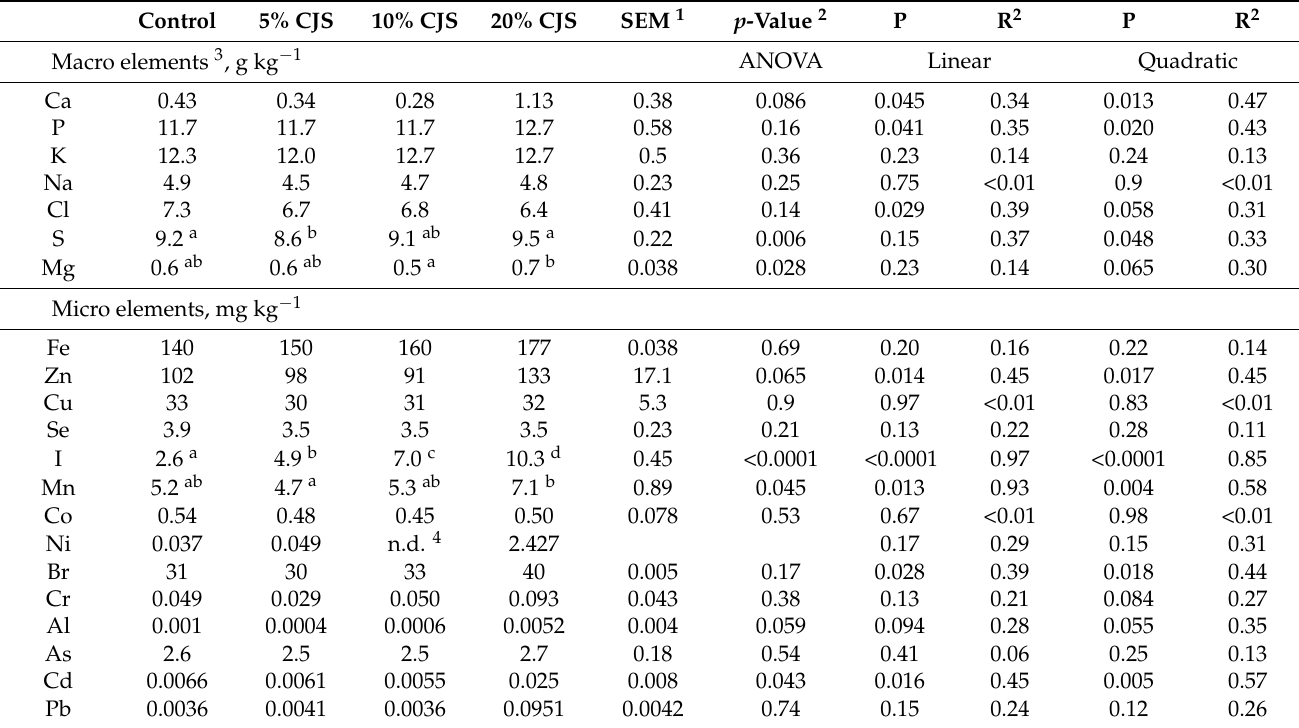
Table 9. Macro and micro minerals present in the liver of Atlantic salmon ( Salmo salar ) from the retention experiment where salmon were fed increasing dietary level of Cyberlindnera jadinii